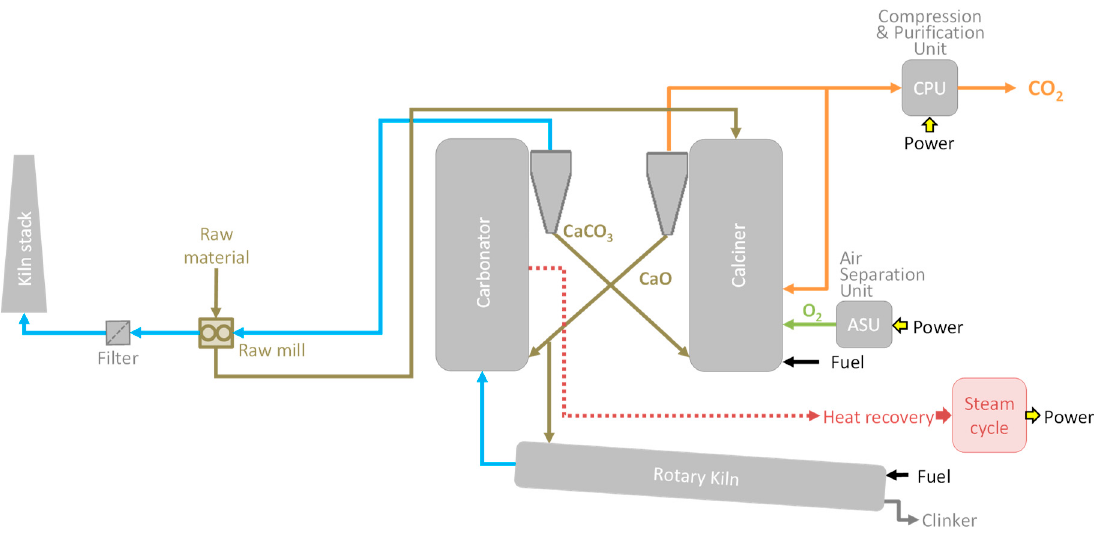
Figure 12. Simplified diagram flow of a CaL process installed in a cement plant: integrated configuration (adapted from [46]).